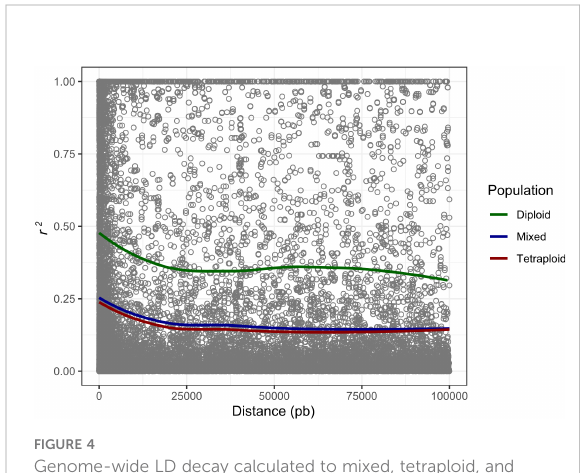
FIGURE 4 Genome-wide LD decay calculated to mixed, tetraploid, and diploid populations. The x-axis represents the physical distance in base pairs (pb) and the y-axis represents the average pairwise correlation coef fi cient ( r 2 ) of